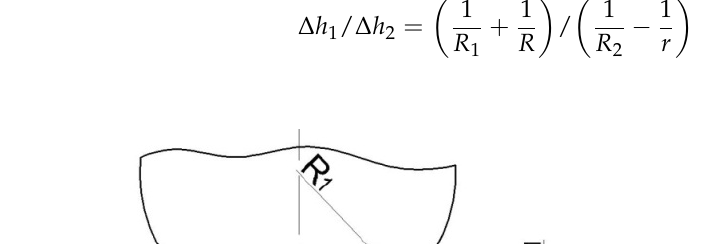
Figure 8. Deformation response of bimetallic materials during equiaxed compression: ( a ) strain rate-stress response, ( b ) isostrain behavior, and ( c ) isostress behavior (Reprinted with permission from Ref. [40], image on page 172. 1996, Taylor and Francis).